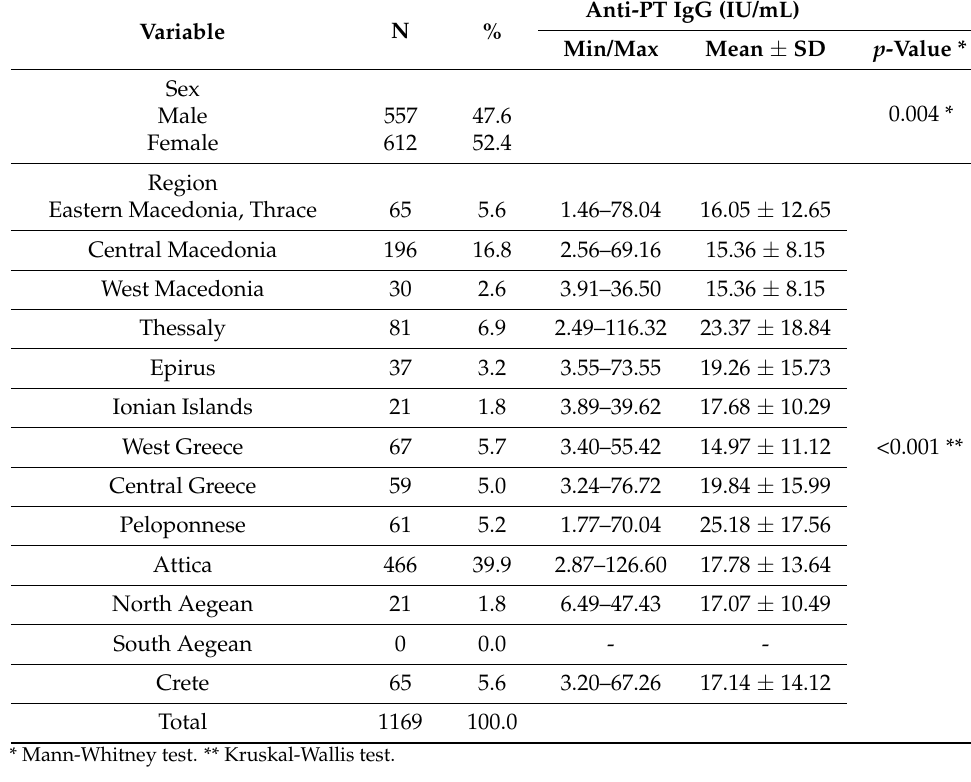
Table 1. Participants and sample distribution.